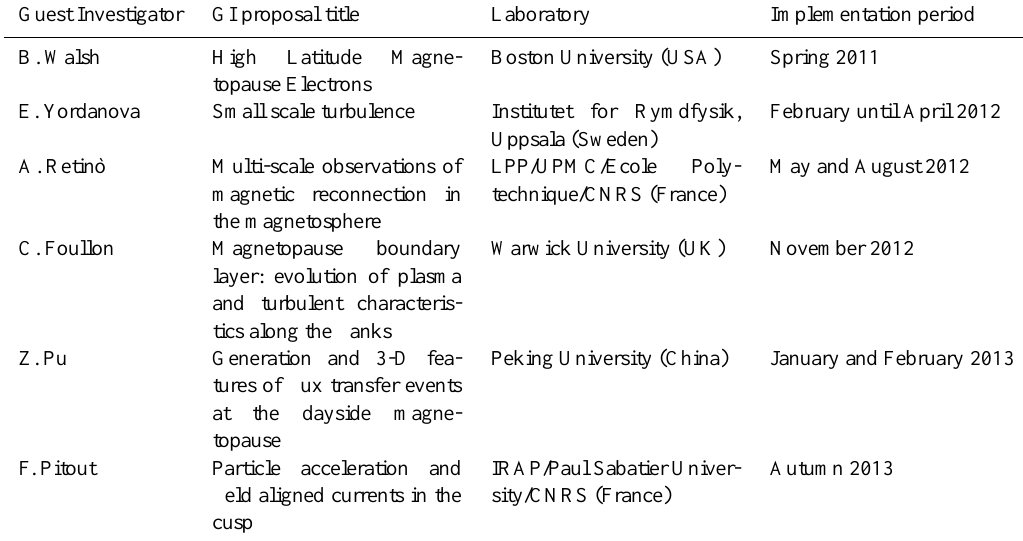
Table 5. List of Cluster Guest Investigators selected in 2011. Guest Investigator